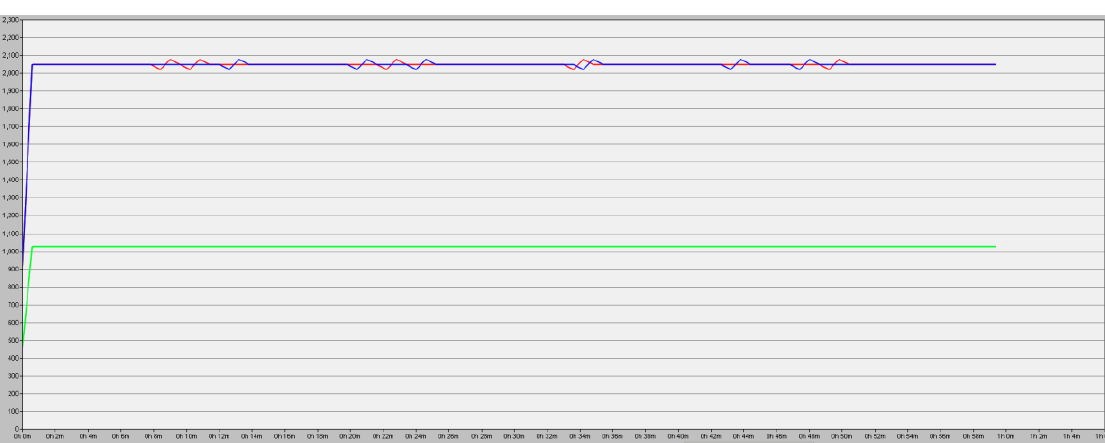
Figure 7. Improvement of Energy Efficiency (1). (X axis: Time, Y axis: Energy efficiency).